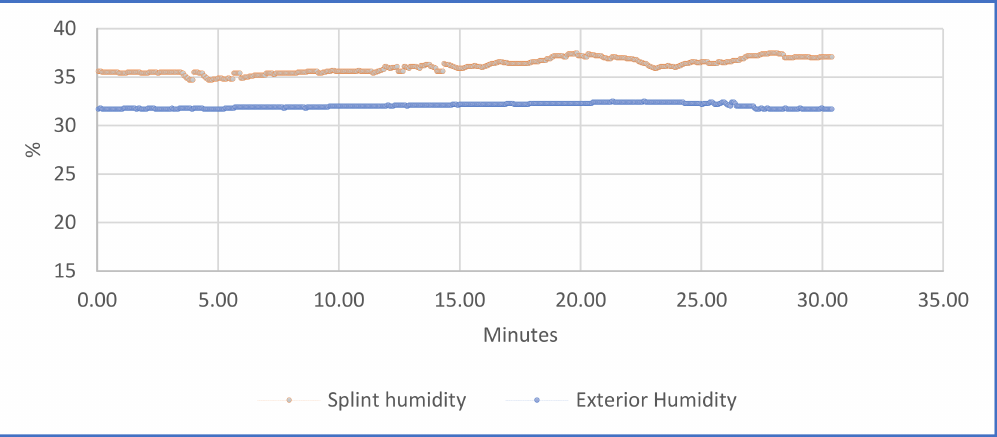
Figure 16. Humidity